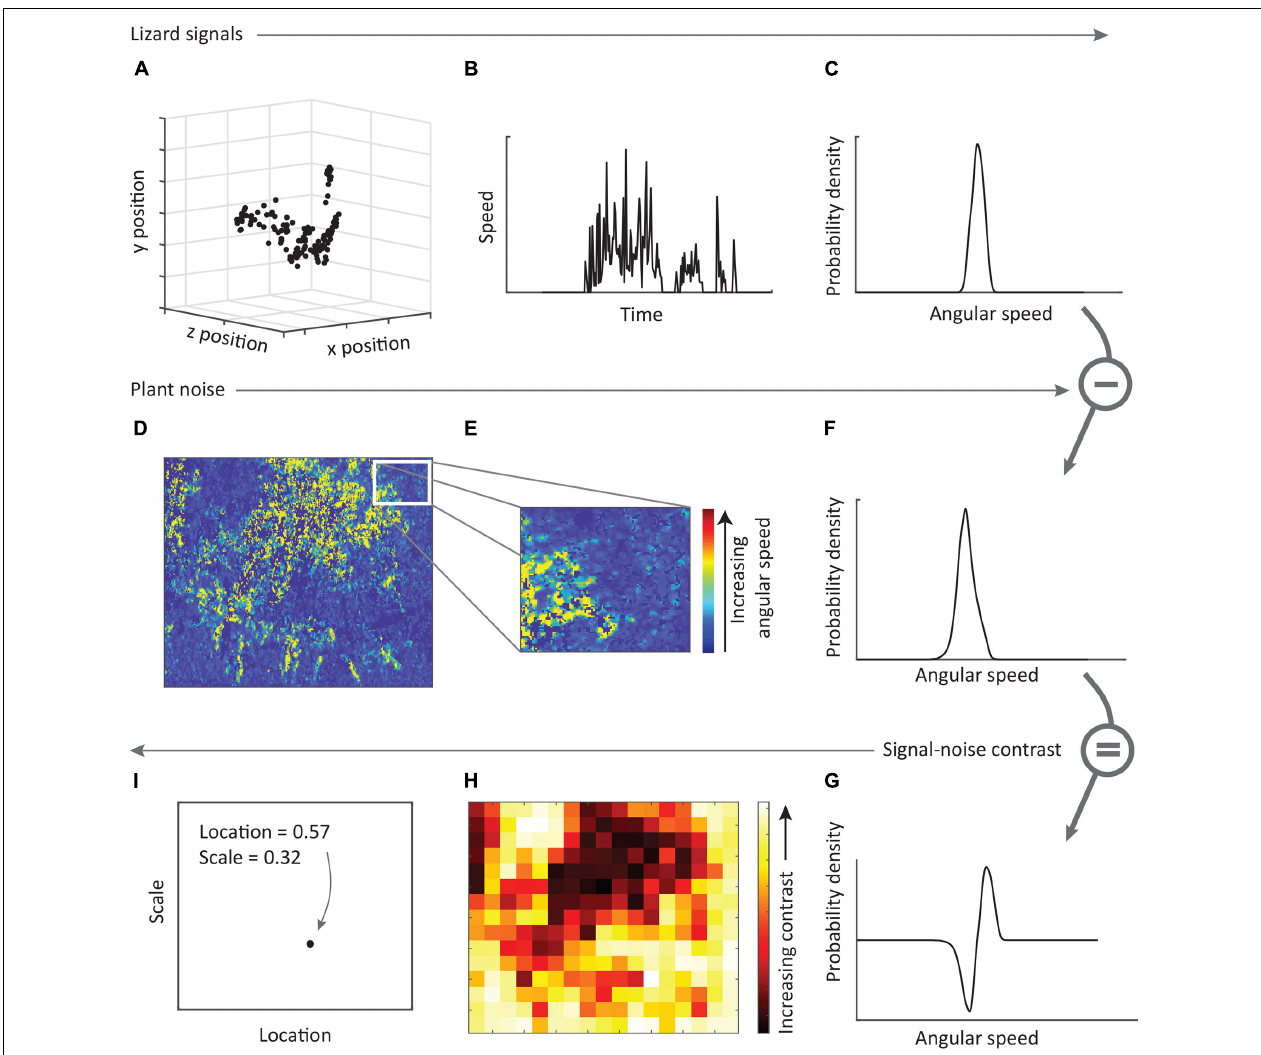
FIGURE 2 | A summary of the approach used to compare lizard signals with plant noise. (A) Lizard displays are digitized to generate x-y-z coordinates representing the position of a given feature in 3D space (see text). (B) Speeds are calculated from the change in position of the feature over time, and (C) probability density vector computed to yield the probability of occurrence of different angular speeds. (D) Footage of plant movement in response to wind is analyzed using gradient detectors (see text) resulting in estimates of velocity, from which we retain the magnitude (speed) of movement. (E) Sub-regions of these plant speeds are selected and the probability density vector computed (F) . (G) The density vector for plant movements is then subtracted from the density vector for lizards to yield a difference vector, which was then integrated for all sections greater than zero to produce difference score in the range [0,1]. The process was repeated with the remaining subregions of the plant footage, resulting in a matrix of difference scores (H) . (I) The median difference score (location) and a measure of the spread of difference scores (scale) was then computed to produce the final contrast score for this lizard display and plant.